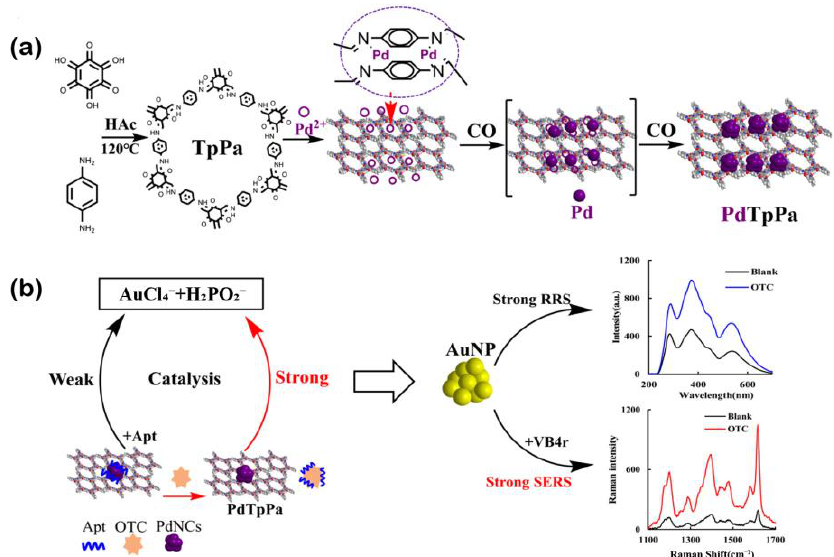
Figure 5. ( a ) Preparation of PdTpPa and ( b ) principle of aptamer-mediated PdTpPa-catalyzed gold nanoreaction SERS/RRS dual-mode determination of oxytetracycline (OTC). Reprinted with permission from [68].Copyright 2021 American Chemical Society.